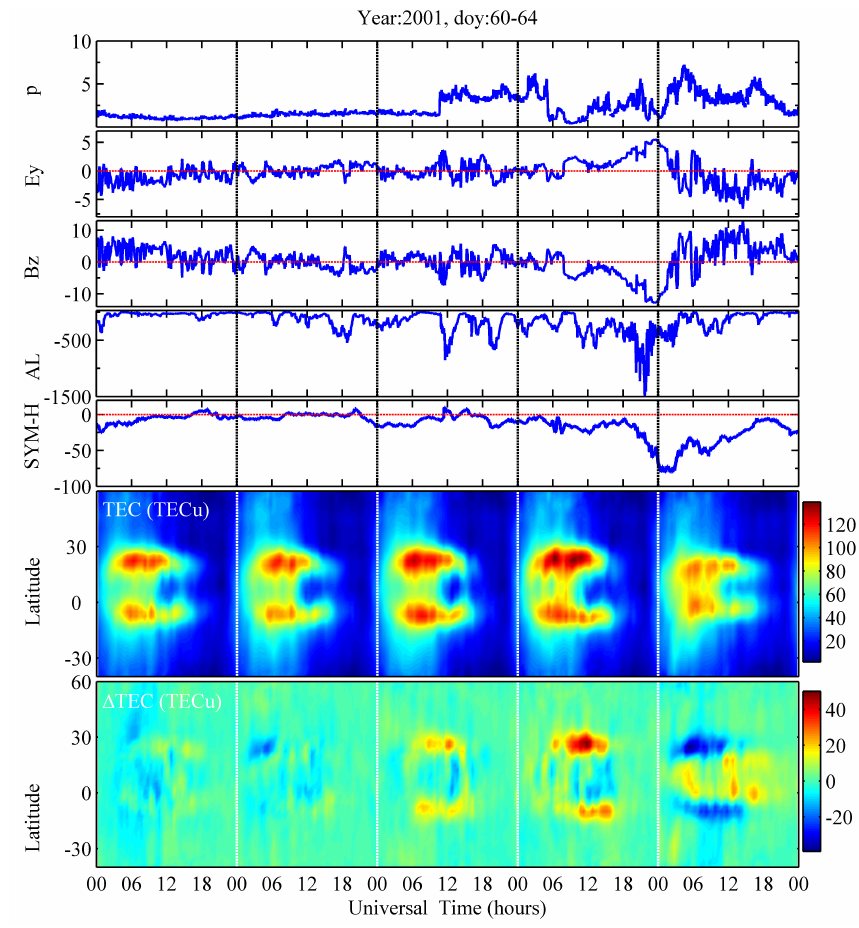
Fig. 4. Same as Fig. 1, but for 1–5 March (days 60–64) 2001. TEC were enhanced at low latitudes in both hemispheres on 4 March